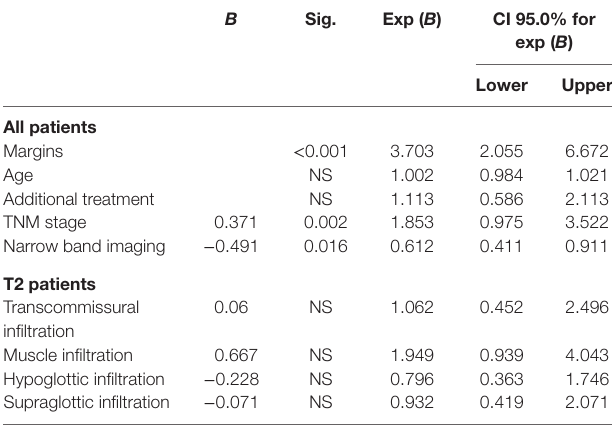
Table 2 | Cox regression analysis of factors affecting recurrence-free survival. B sig. exp ( B ) ci 95.0% for exp ( B ) lower